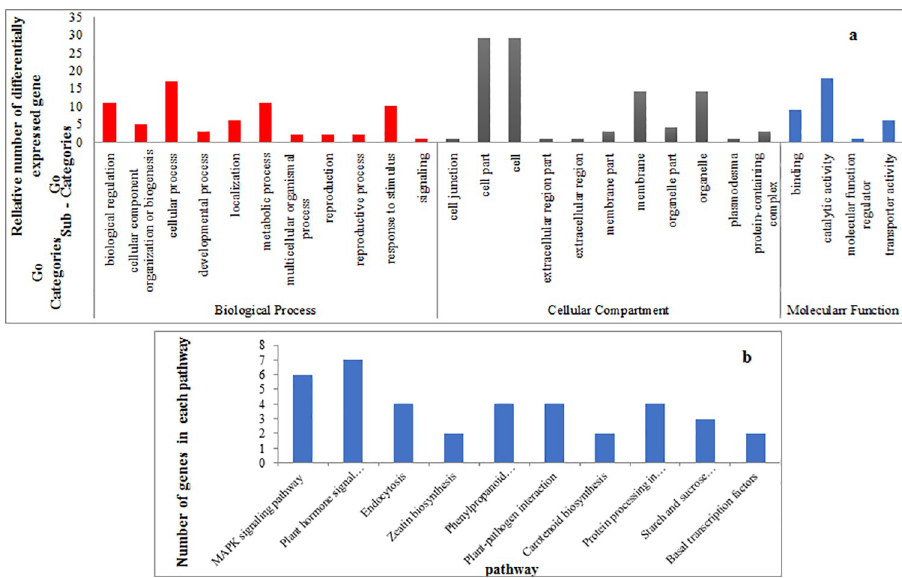
Fig 5. Functional enrichment analysis for differential miRNAs’ target. (a) GO annotation of target genes. Y-axis (right) represents the actual gene number. The genes were annotated in three main categories including biological progress, cellular component, and molecular function (X-axis). (b) Functional annotation of KEGG pathways by KEGG database.